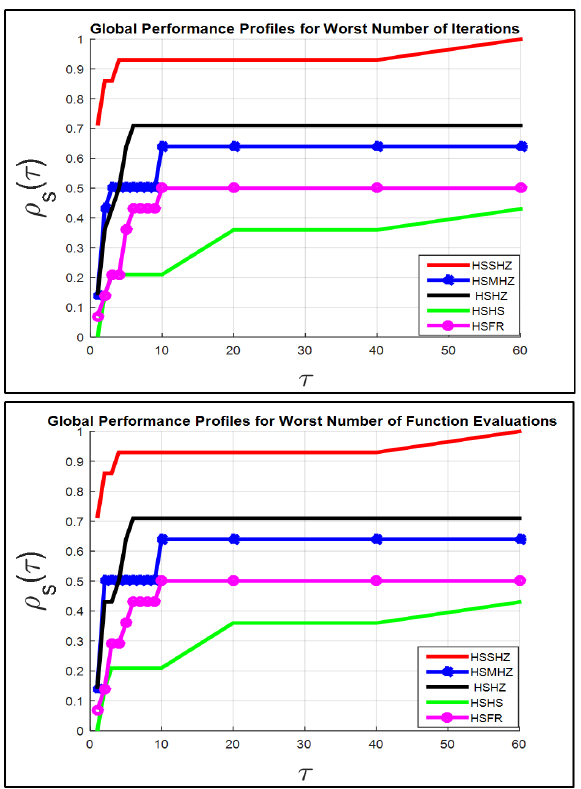
Figure 5. Plotting the results of the terms itr.w and FEs.w for 5